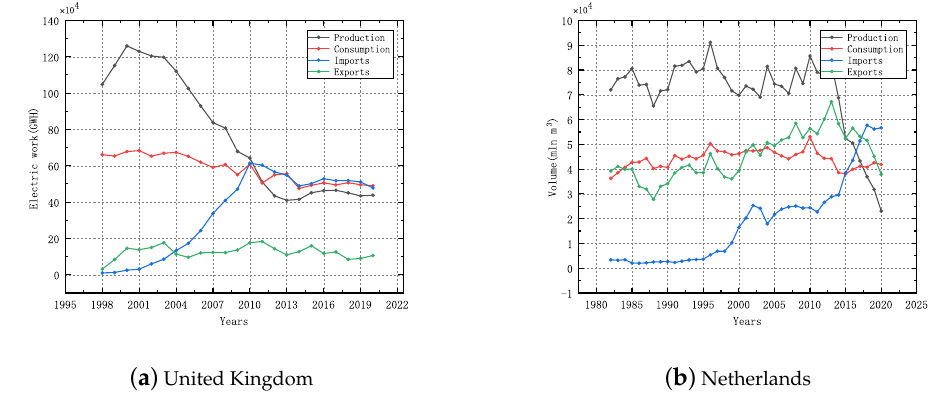
Figure 1. Overview of natural gas demand and supply of UK and